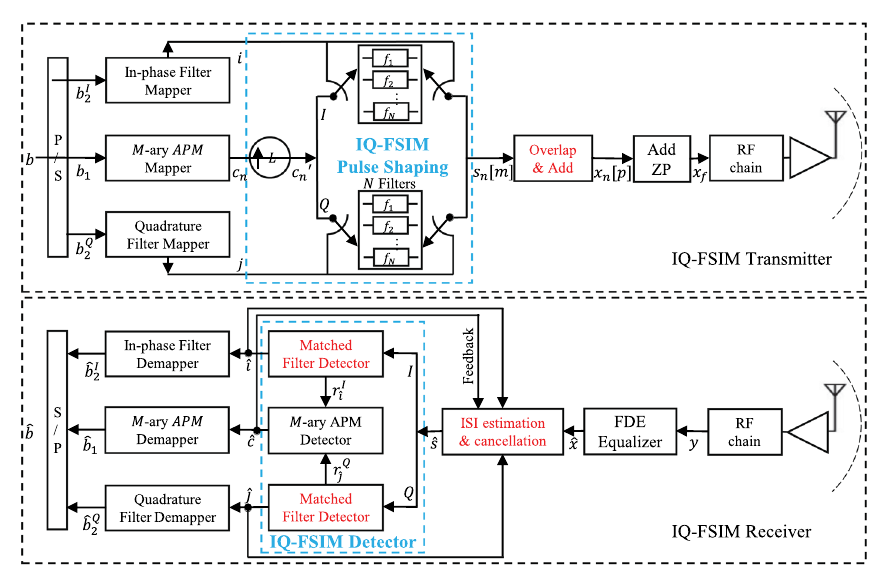
Fig. 1 Block diagram of the proposed IQ-FSIM